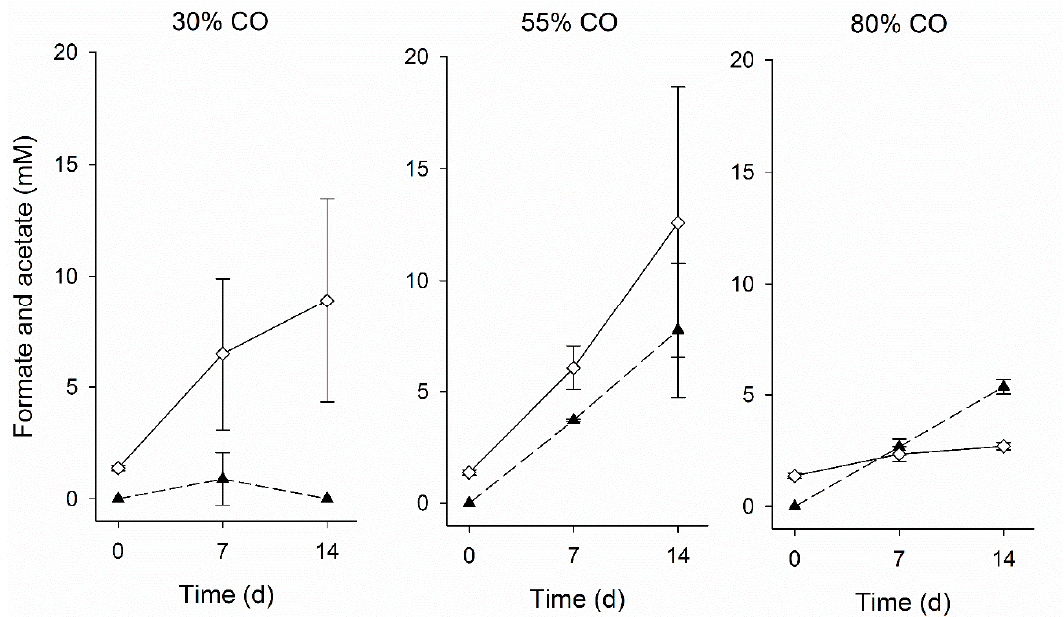
Figure 5. Formate ( ▲ ) and acetate ( ◊ ) production during the batch tests with biomass from day 54 incubated with 30%, 55%, and 80% CO in the gas phase. The vertical bars indicate the standard deviation among triplicates.